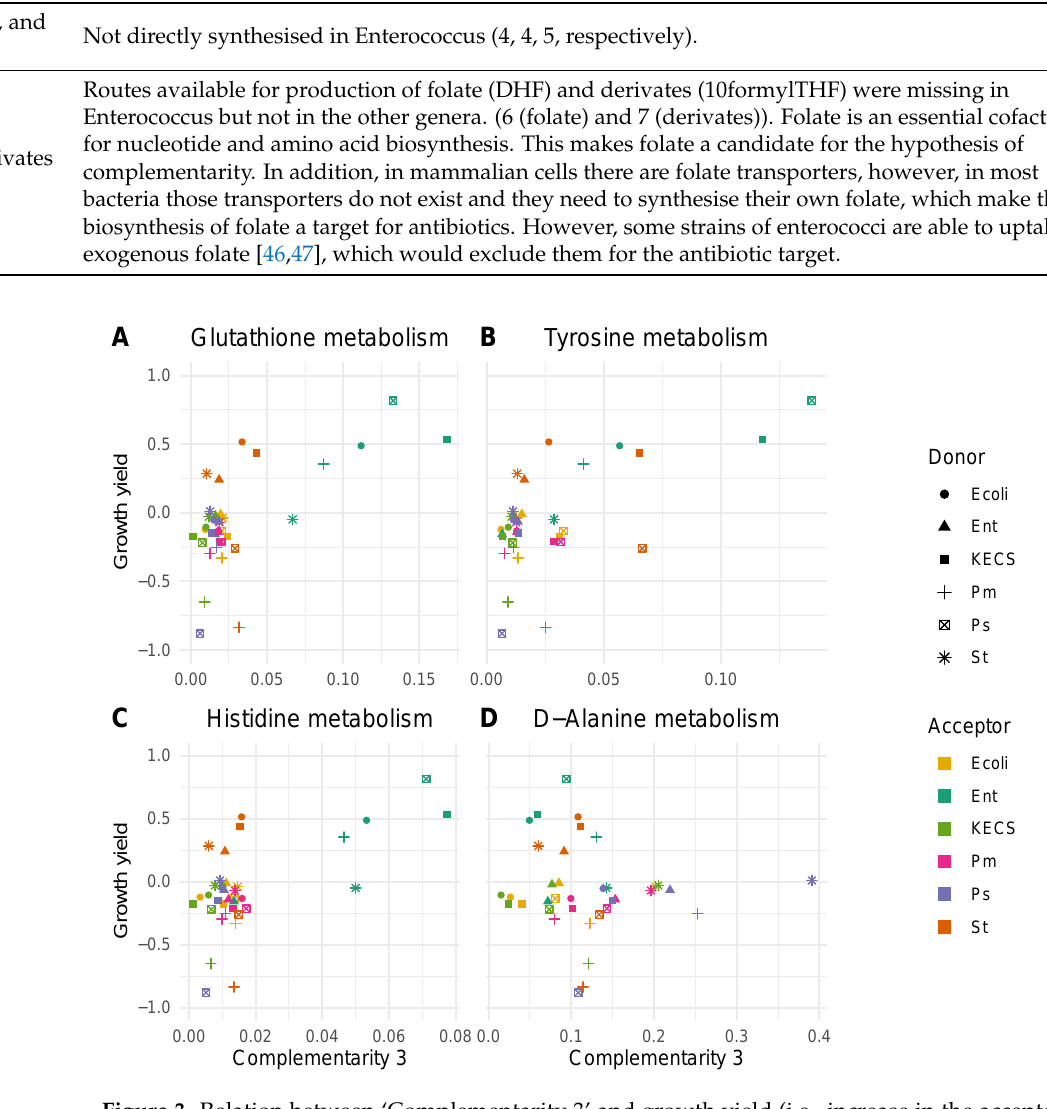
Figure 3. Relation between ‘Complementarity 3’ and growth yield (i.e., increase in the acceptor’s growth yield as seen in [5]). Each dot represents a pair acceptor-donor. This information is described in the right-hand legend. The first two pathways, ( A ) and ( B ), belong to the top-rank pathways in Table 1. They show a higher complementarity for the pairs for which the growth yield is higher, and vice versa. ( C ) represents the Histidine metabolism pathway. It was selected as another pathway of interest, and it shows a similar behaviour. On the other hand, in ( D ), the pathway D-Alanine metabolism was chosen as a low-rank pathway. In this case, there is no correlation between the complementarity measure and the growth yield